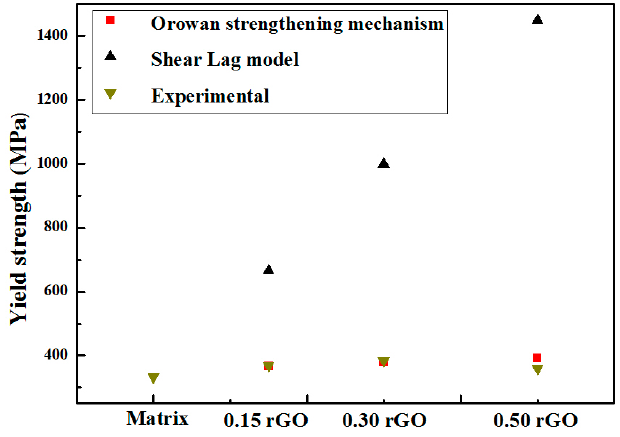
Figure 12. Comparison of yield strength calculated by different models and experimental data.